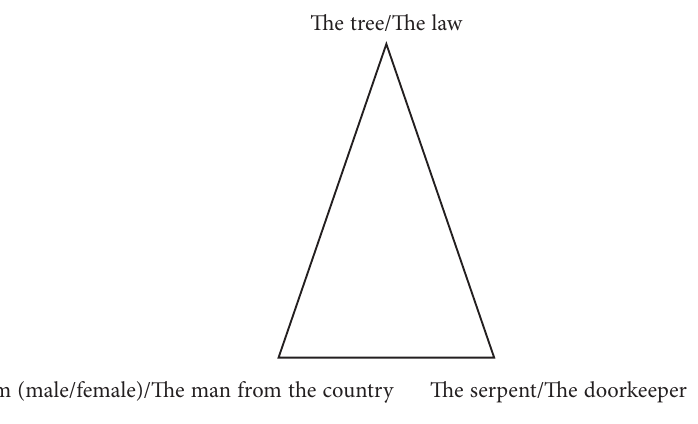
Figure 1. The triangle in Kafka and Genesis (source: created